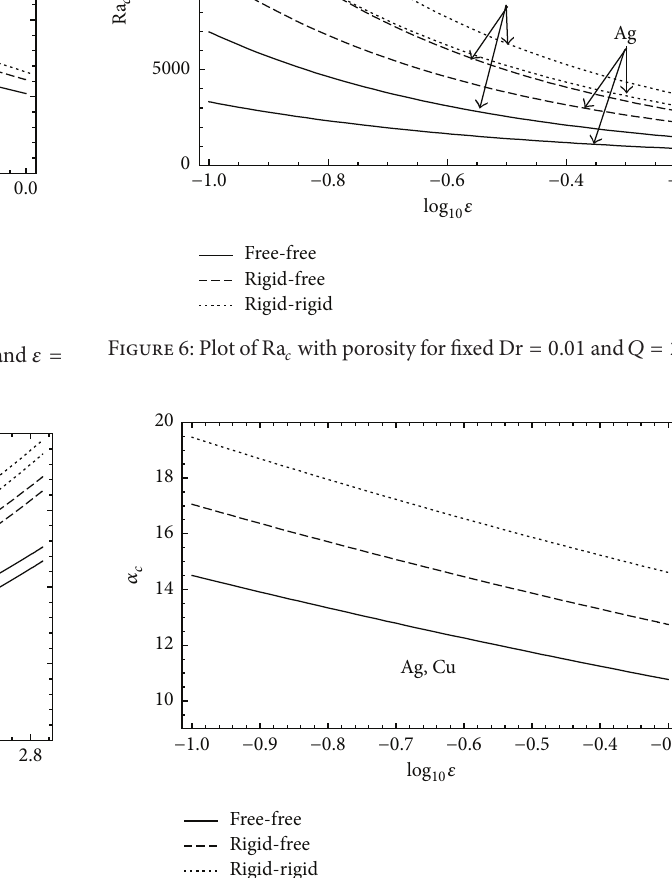
Figure 4: Plot of Ra 𝑐 with Chandrasekhar number for fixed Dr = 0.01 and 𝜀 = 0.4 .